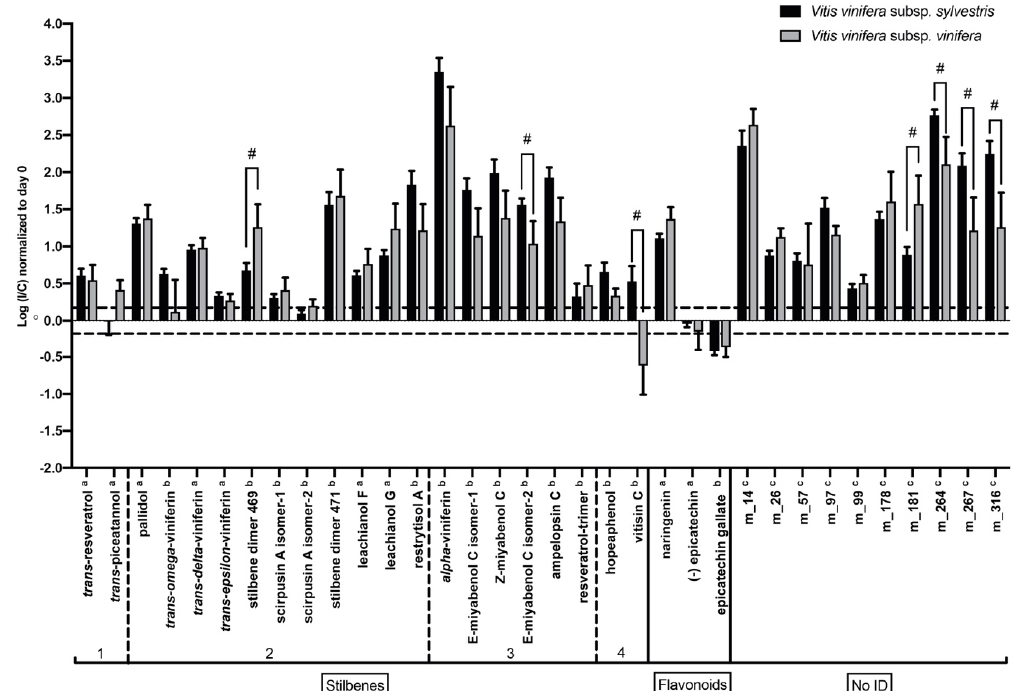
Figure 5. Changes in specialized metabolite contents significantly affected at three DPI. Contents are expressed as the log of the ratio between content (normalized to T0) in inoculated sample (I) and content in mock-inoculated control sample (C). Metabolite contents are represented in black for V. v. subsp. sylvestris and in gray for V. v. subsp. vinifera . # represents a (I / C) statistically significantly different for V. v. subsp. sylvestris and V. v. subsp. vinifera ( p < 0.05). a indicates confirmed identification with standard, b indicates putative metabolites identified by MS/MS, and c indicates non-characterized metabolites. Error bars represent standard error of the mean. For stilbenes, 1-2-3 and 4 indicates monomeric, dimeric, trimeric and tetrameric forms, respectively.